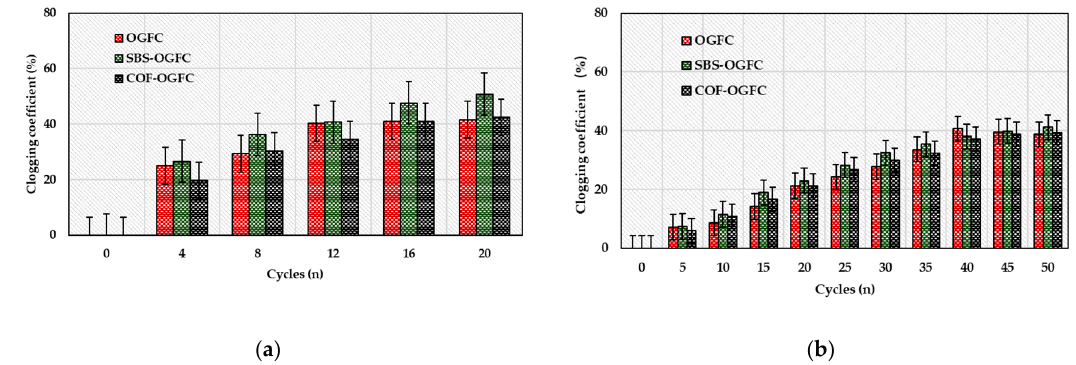
Figure 11. Clogging coefficient of three mixtures with different cycles. ( a ) Spring clogging procedure; ( b ) Summer clogging procedure.